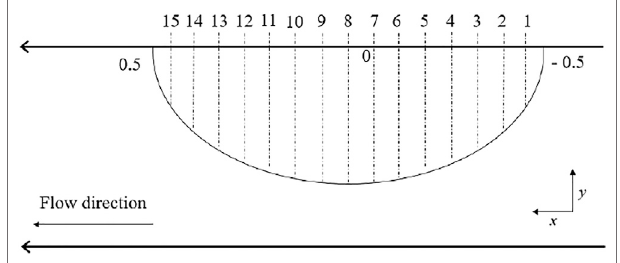
FIGURE 6 | Measurement sections of the experiment.